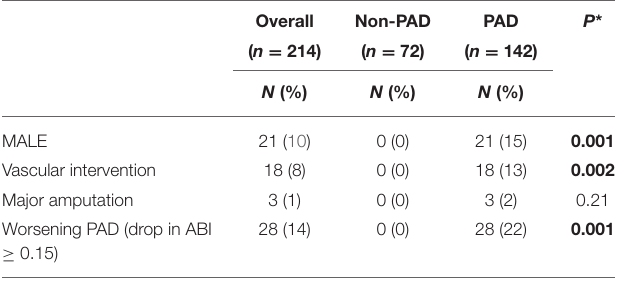
TABLE 2 | Event rates for primary and secondary outcomes.